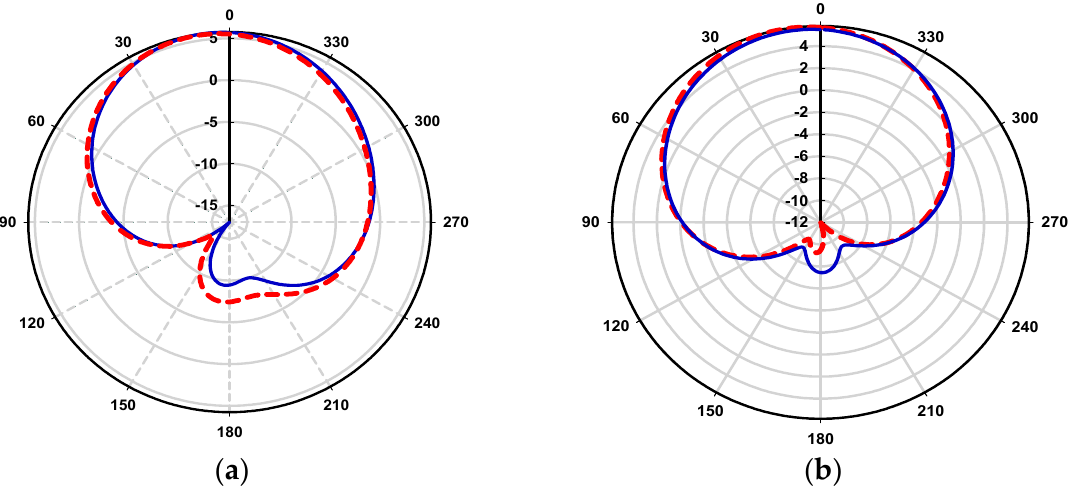
Figure 15. Simulated and measured radiation patterns at 9.44 GHz in ( a ) XY plane (E-field), and ( b ) YZ plane (H-field) of the proposed design.